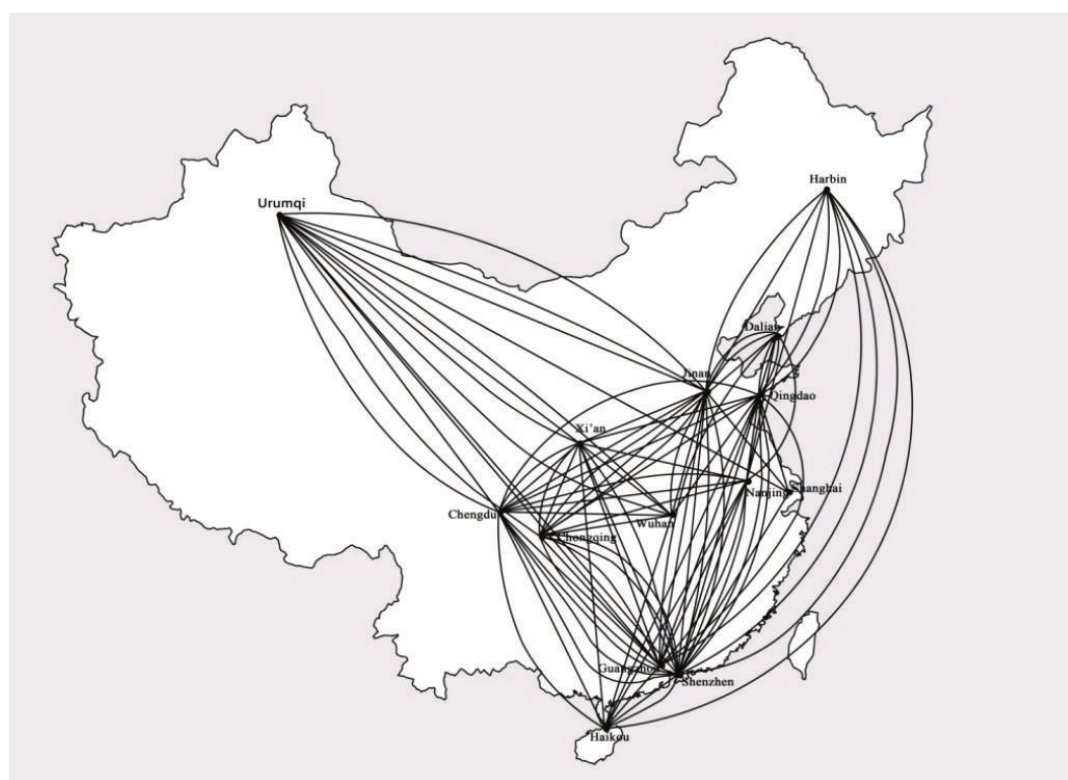
Figure 2: Chinese airline